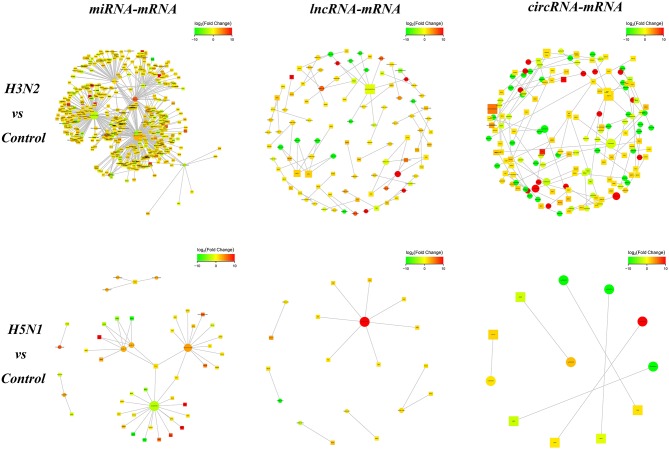
The network diagram of ncRNA and mRNA interactions. Square nodes indicate ncRNAs, round nodes indicate mRNAs, and the edges indicate the interactions between the two genes. The size of the node is proportional to the connectivity (degree) of the node; namely, the more edges are connected to the node, the larger the degree of the node, indicating that the gene is more important in the network. The color of the node represents the difference in gene expression in this group of samples, namely, the logFC value; green represents downregulation, red represents upregulation, and the color depth represents differences in the altered expression.